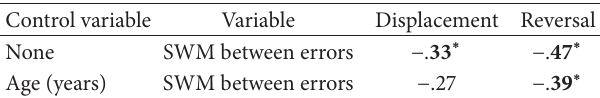
Table 3: Partial correlation between SWM between errors and displacementandreversaladaptation,respectively,whilecontrolling the effect of age. Asterisk ( ∗ ) denotes that correlation is significant at the 0.05